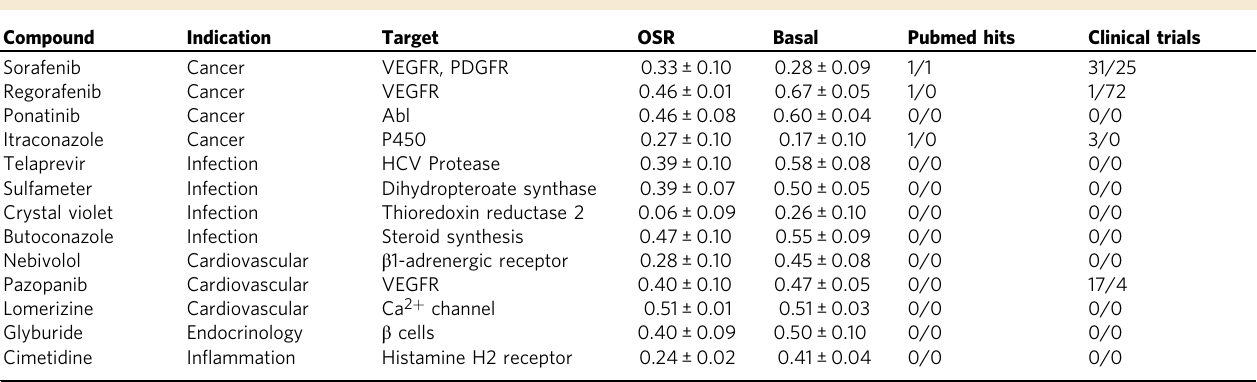
Table 1 Potent inhibitors of mitochondrial